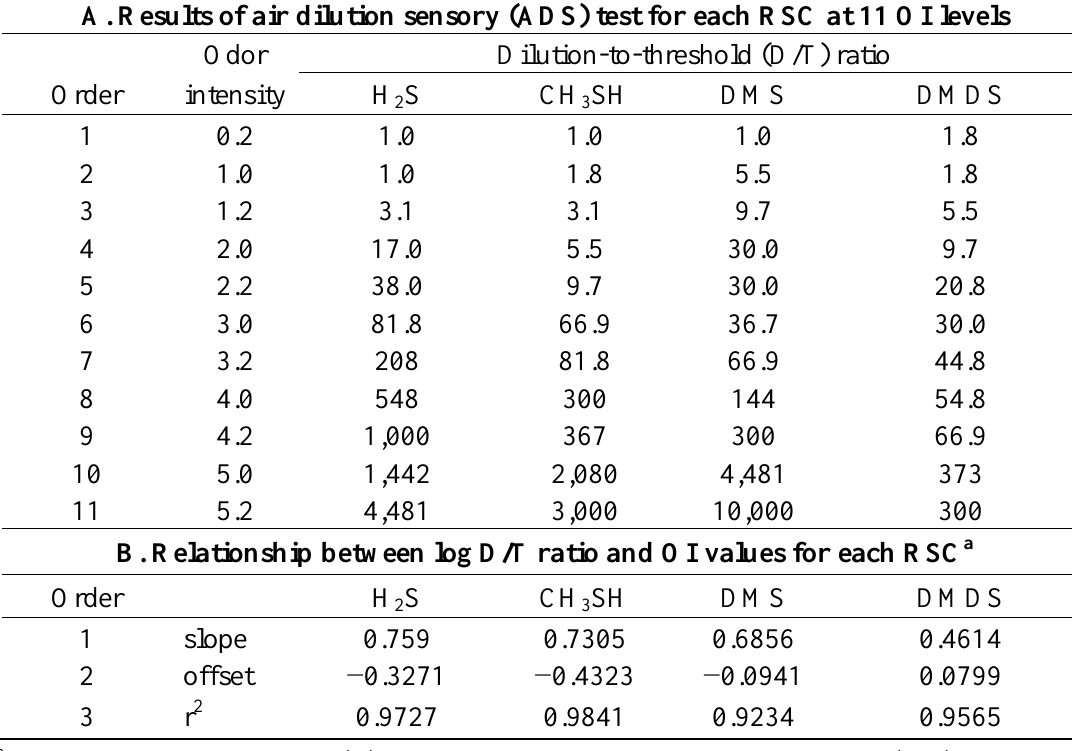
Table 3. Derivation of empirical relationship between OI and D/T ratio for each